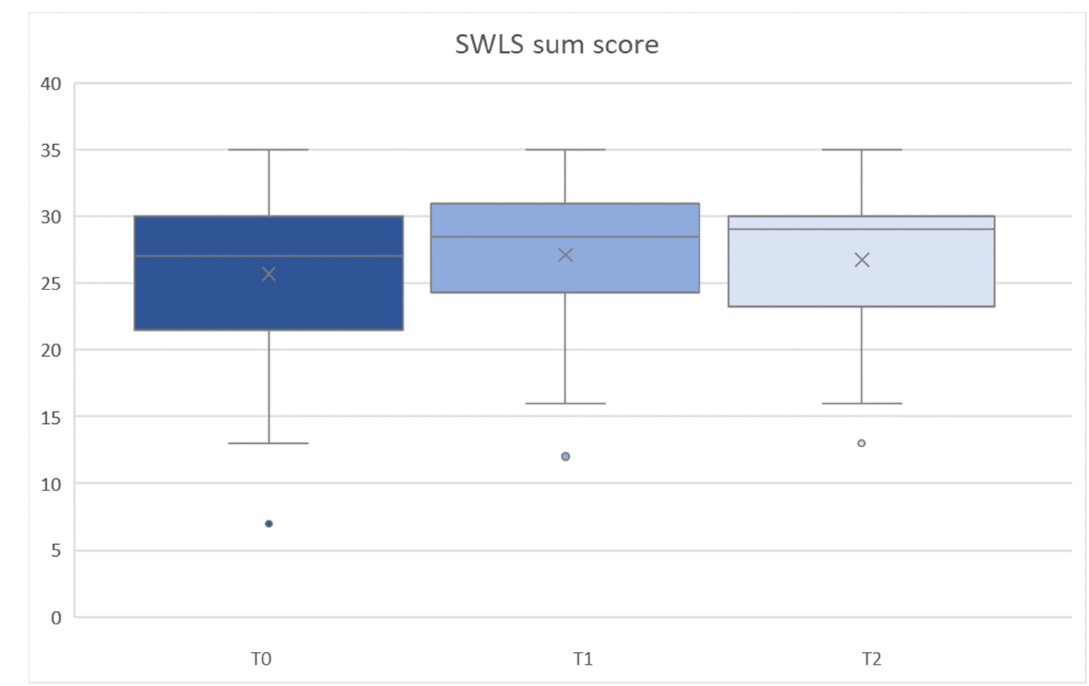
Figure 2. SWLS sum score at all assessment times (T0/T1/T2). Table 4. SWLS sum score for all parameters investigated and times of assessment (T0/T1/T2). SD: standard deviation.